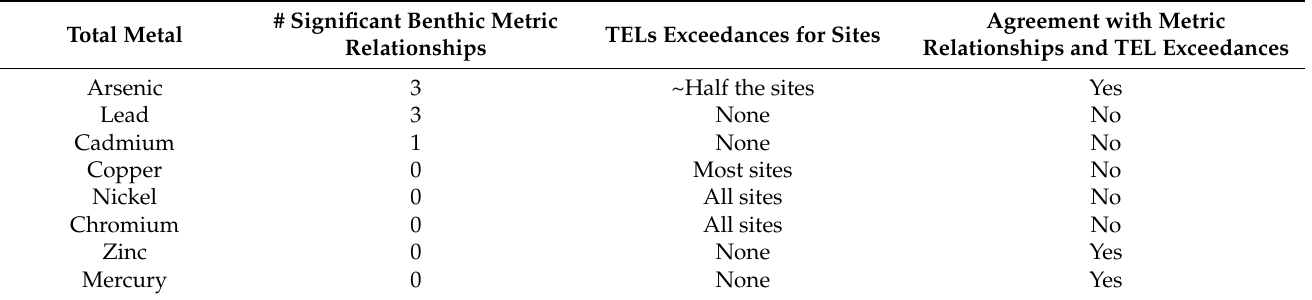
Table 4. Comparison of the statistically significant and ecologically meaningful benthic metric relationships with the total metals TEL exceedances. ~ means